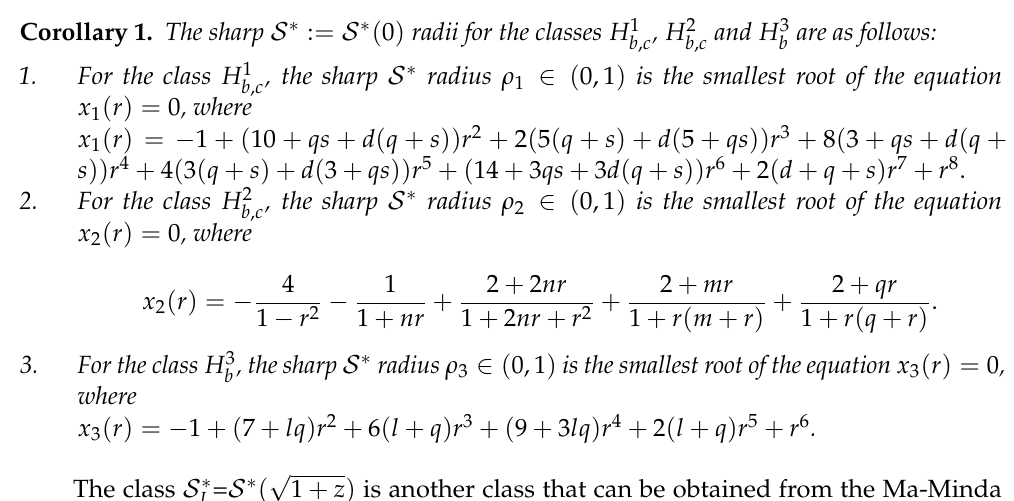
( H 1 ) , R ( H 2 ) and R ) S ∗ ( 1 ) 1,1 1,1 2 2